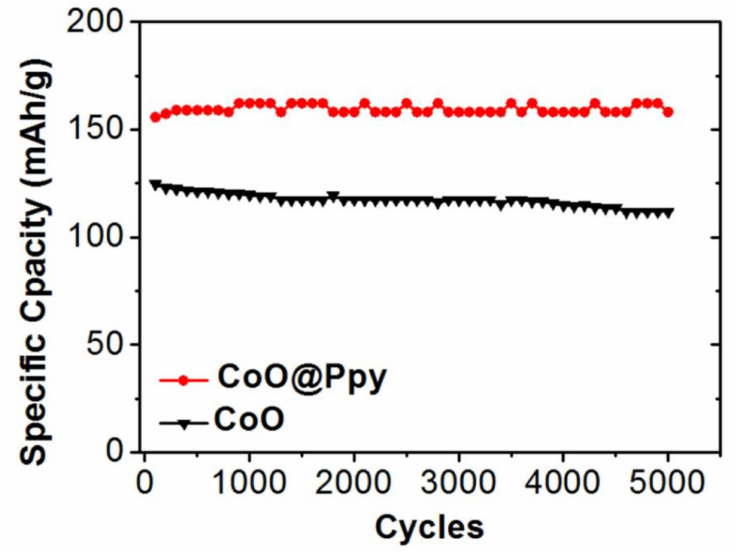
Figure 4. Cycling stability test of the CoO nanowires and the core-shell CoO@Ppy nanoarrays.